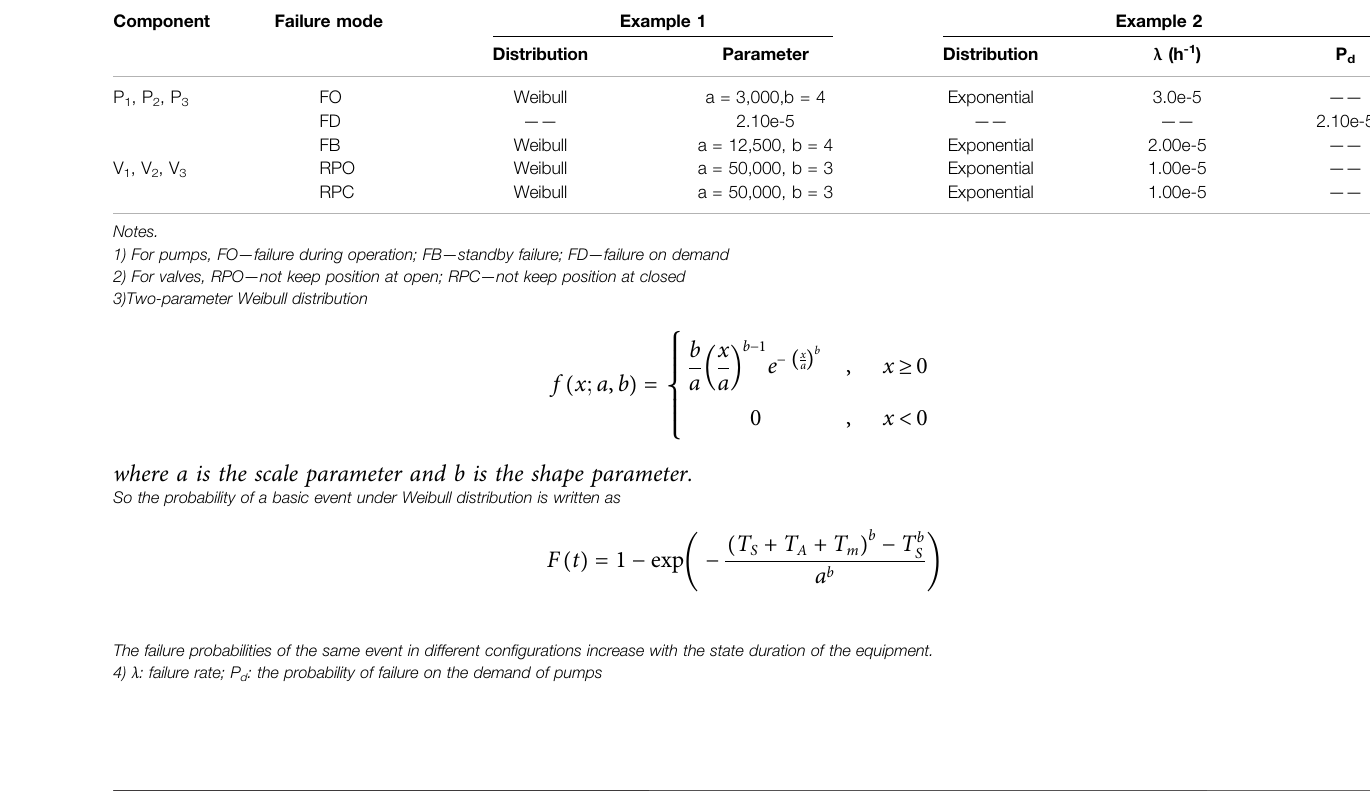
TABLE 1A | Reliability parameters of failure